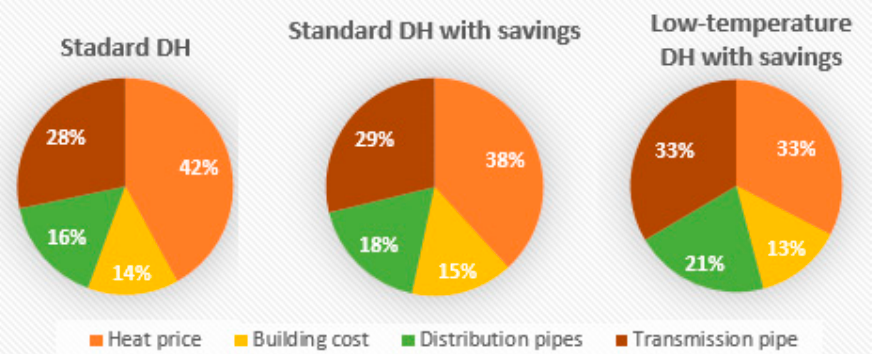
Figure 9. The average percentage share of costs in the three scenarios.